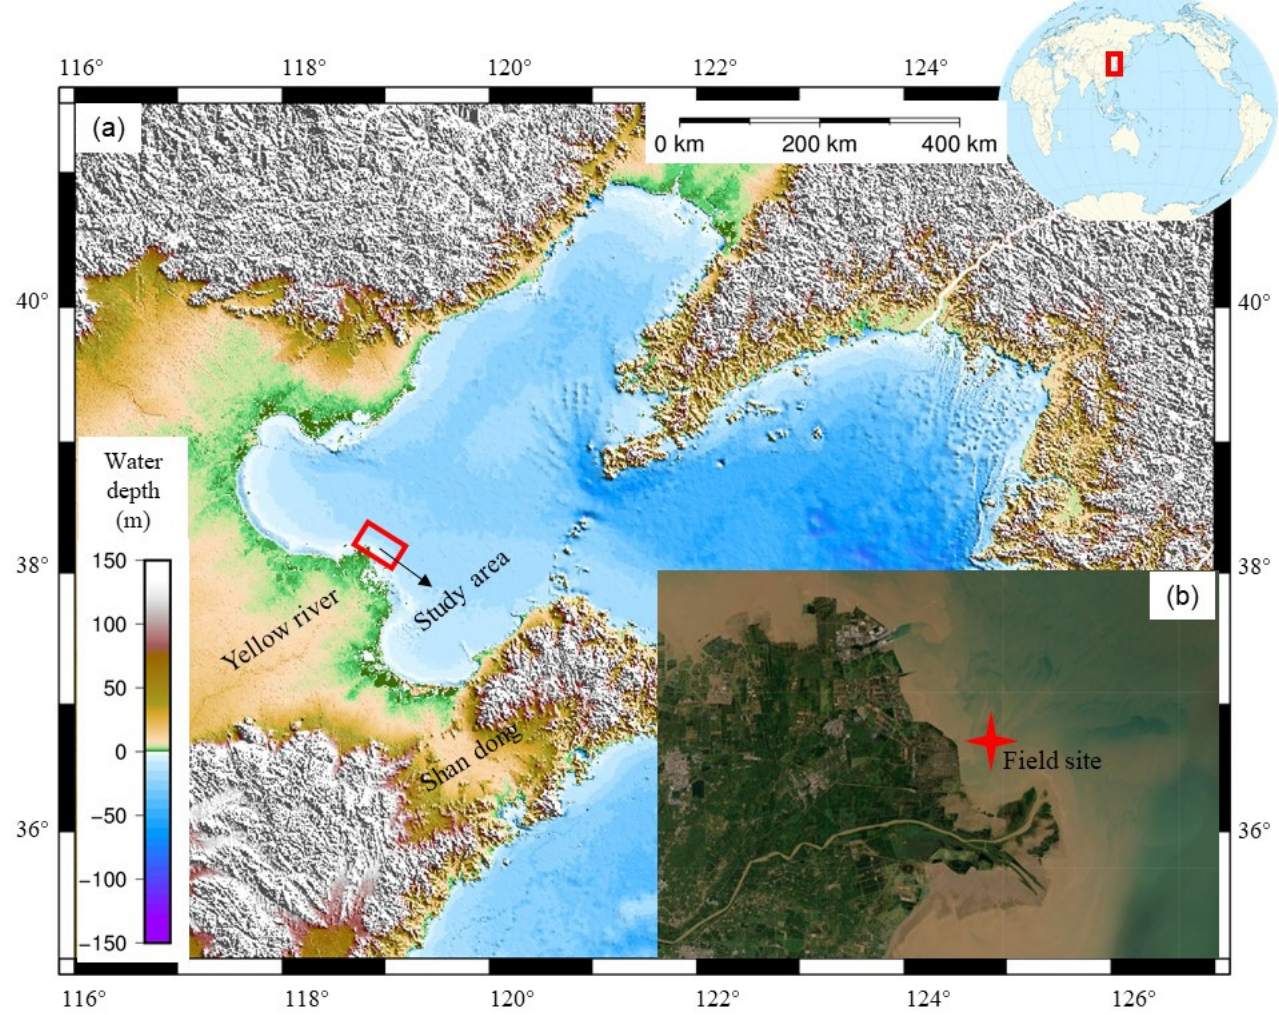
Figure 2. Location map of the study area ( a ) and in situ test site ( b ).